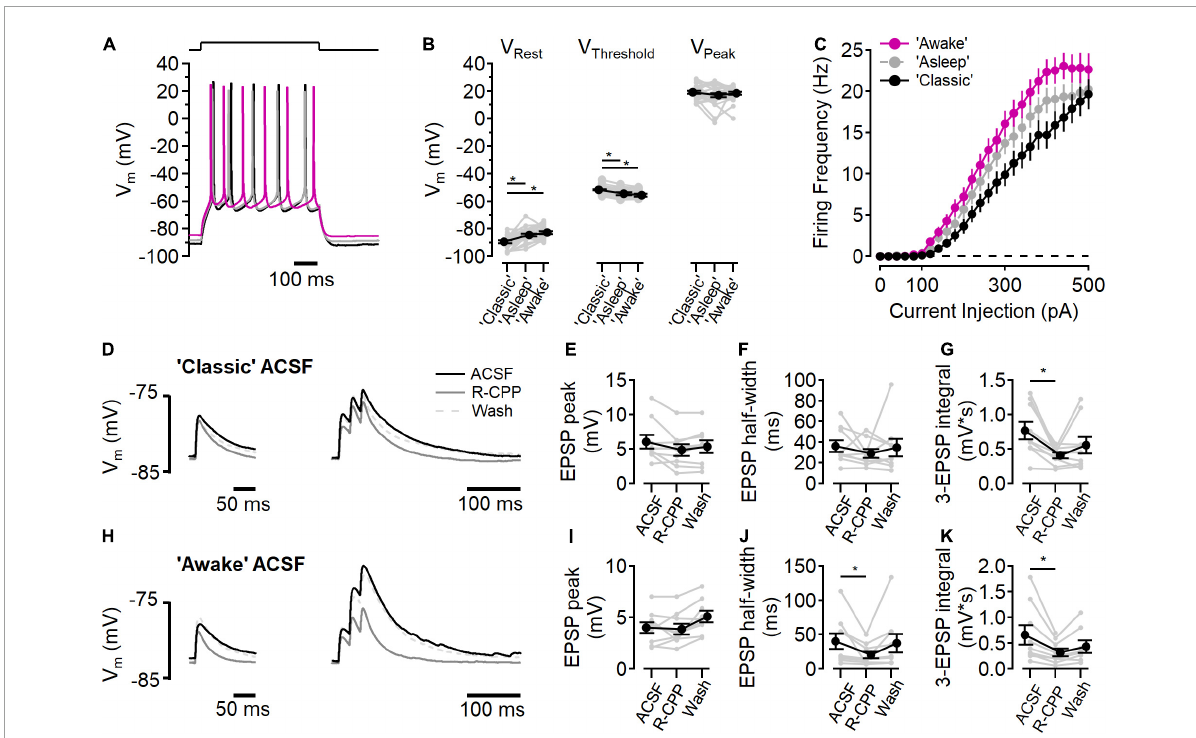
FIGURE6 NMDARs contribute to synaptic integration. (A–C) Current clamp recordings in “awake” (fuchsia), “asleep” (gray), and “classic” ACSF conditions. (A) Example voltage traces in each condition in response to a current step to stimulate action potential firing. (B) Measurements of resting membrane potential (V Rest ), action potential threshold (V Threshold ), and the peak voltage of the action potential (V Peak ) in each ACSF condition [for V Rest , Friedman test statistic = 25.4 (6.0), p = 3.0E-6; “classic” versus “asleep” p = 1.6E-5, “classic” versus “awake,” p = 3.7E-7, Wilcoxon rank-sum test; for V Threshold , Friedman test statistic = 28.1 (6.0), p = 8.0E-7; “classic” versus “asleep” p = 1.9E-5, “classic” versus “awake,” p = 3.0E-8, Wilcoxon rank-sum test; for V Peak Friedman test statistic = 0.2 (6.0), p = 0.89; N = 27]. (C) Action potential firing frequency as